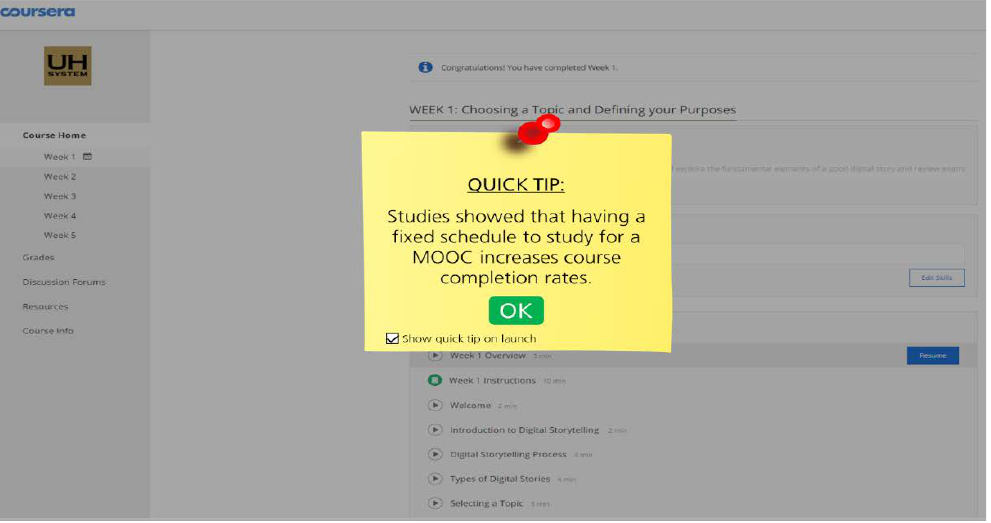
Figure 1. An illustration of a quick tip pop-up providing a suggestion related to study goals.